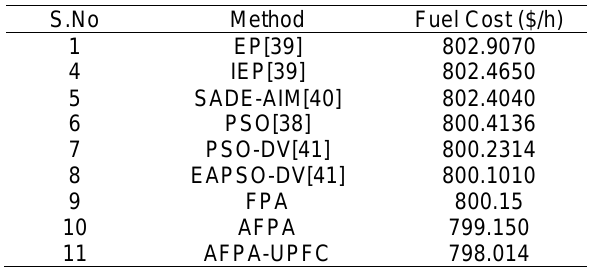
Table 4. Fuel cost comparison for different techniques